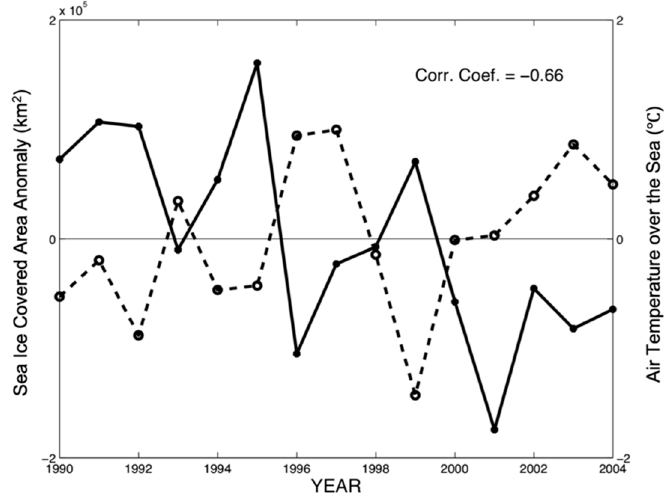
Figure 9. Correlation between the time series of annual sea ice covered area anomaly (solid line, unit: km 2 ) and sea surface air temperature (dashed line, unit: °C). The sea ice data are from the ROMS solution, and the air temperature data from the NCEP. The sea-ice area anomalies are the yearly mean average minus the 15 year average.